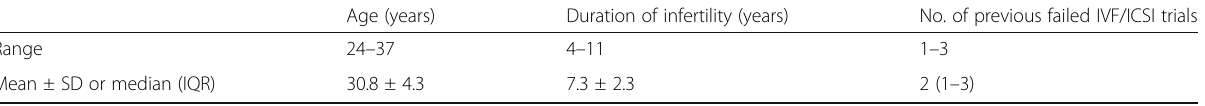
Table 1 Demographic data of studied women